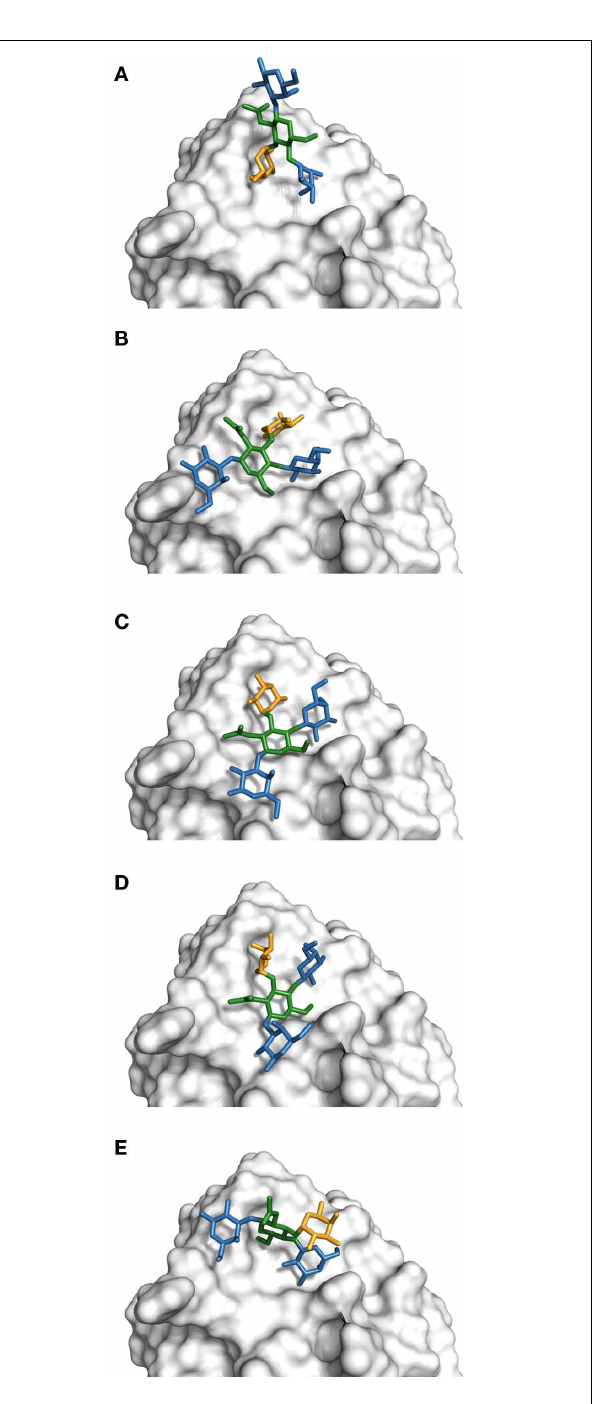
FIGURE 4 | Rotation of the GlcNAc β (1 → 3)Gal linkage allows many different tetrasaccharide binding modes with DC-SIGN. (A) Crystal structure binding mode ( φ =− 84.2, ψ =− 157.4; PDB code 1SL5). (B) Top ranked binding mode ( φ =− 76.6, ψ =− 126.8). (C) Third ranked binding mode ( φ =− 81.8, ψ =− 130.6). (D) Twelfth ranked binding mode ( φ =− 132.4, ψ =− 131.5). (E) Twenty-seventh ranked binding mode ( φ =− 89.6, ψ =− 88.6). Figures (B–E) generated based on representative examples of each conformational cluster of GlcNAc β (1 → 3)Gal linkage (see Figure 3C ) obtained by GOLD docking results. Color guide: blue – galactose, green – N -acetylglucosamine, yellow – fucose.